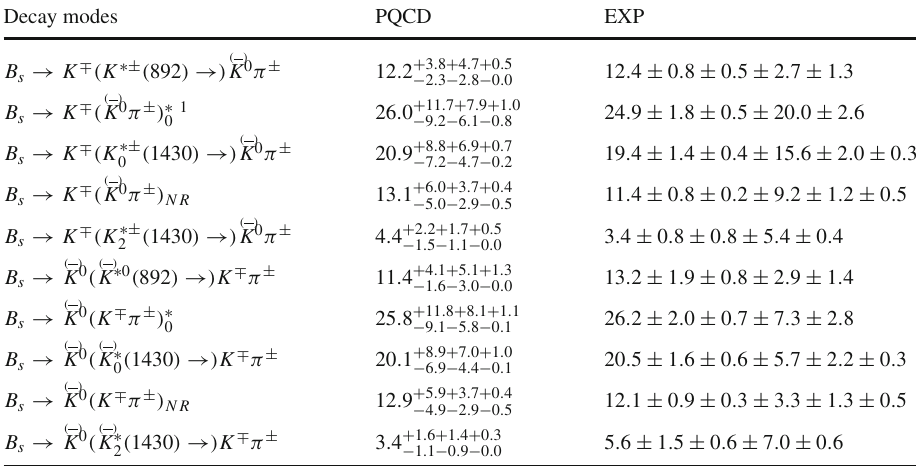
Table 1 The flavour-averaged Decay branching ratios (in 10 − 6 ) of B → K K π decays with ( 1430 ) resonances K ∗ ( 892 ) , K ∗ 0 ( 1430 ) in PQCD and K ∗ 2 approach, together with the experimental data [29]